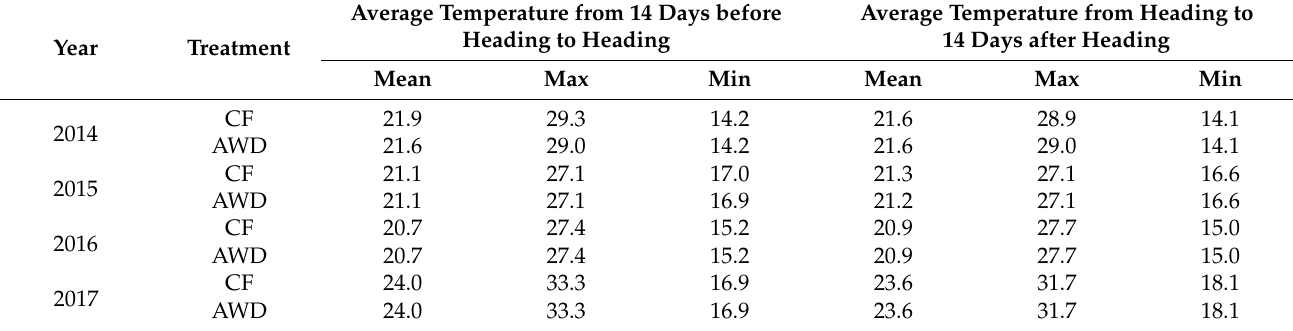
Table 6 shows the average mean, maximum, and minimum temperatures from 14 days before heading to heading, and from heading to 14 days after heading, which greatly affected the filled grain ratio. In 2017, temperatures during the 14-day period before and after heading tended to be higher than other years, while in 2014 and 2016, the minimum temperatures during this period were lower than in 2015 and 2017, respectively, although the mean and maximum temperatures stayed the same as in other years. Table 6. The average mean, maximum, and minimum temperatures from 14 days before heading to heading and from heading to 14 days after heading in the Basmati 370 rice cultivar grown under continuous flooding (CF) and alternate wetting and drying (AWD) during 2014, 2015, 2016, and 2017. Average Temperature from Heading to 14 Days after Heading Year Heading to Heading